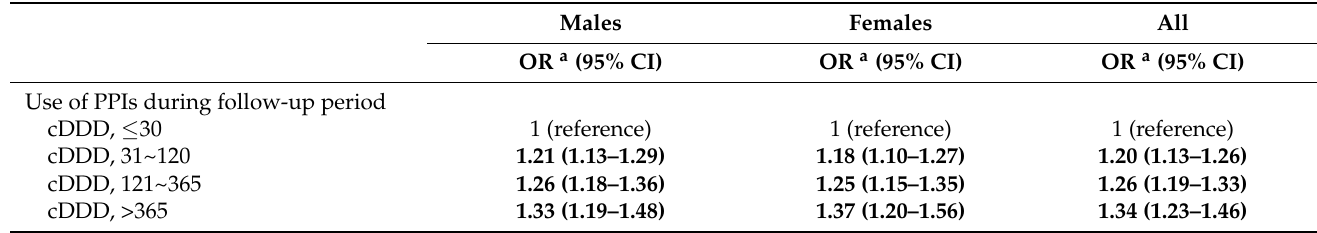
Table 2. Logistical regression models of risk of type 2 diabetes among patients who were exposed to PPIs. Males